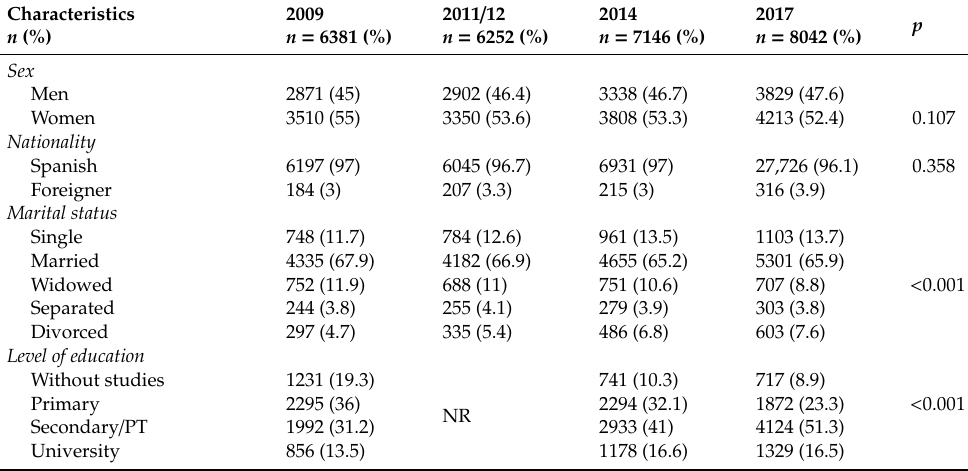
Table 1. Sociodemographic characteristics of Spanish people 50–70 years ( n = 27,821) in the period